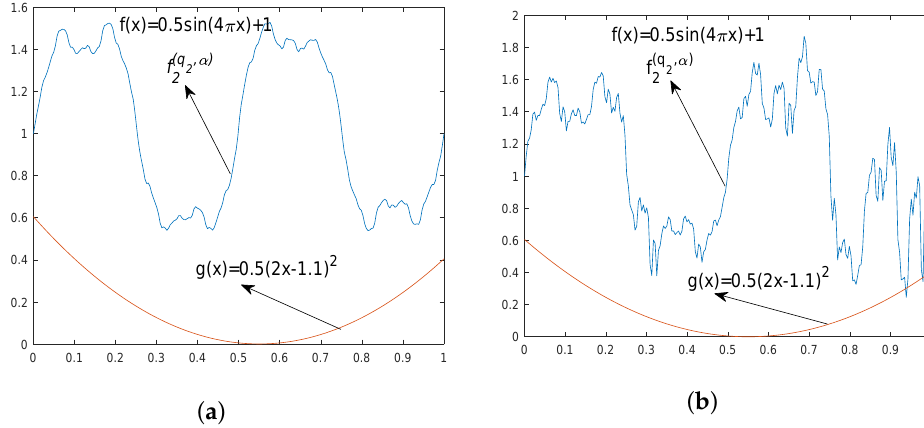
Figure 3. One − sided approximation by MKZ fractal function according to Theorem 5. α satisfies the